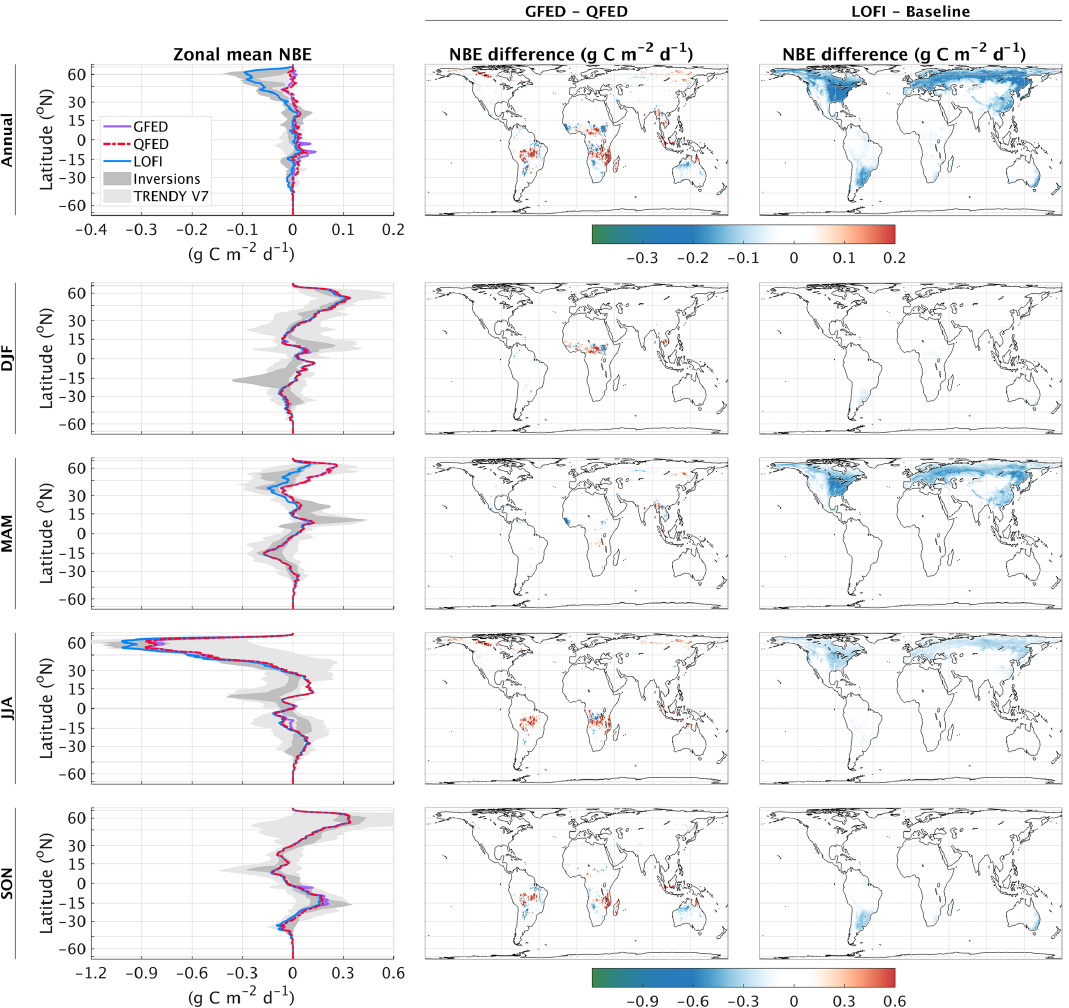
Figure A3. Climatologies (2003–2015) of NBE from the fluxes using GFED (solid purple) and QFED (dash–dot red) biomass burning and the LoFI fluxes (solid blue) for comparison. The first row represents the annual total, and each subsequent row represents a different season. The left column depicts zonal means of the baseline fluxes using GFED and QFED, the range of the inversion ensemble (dark grey), and the range of the TRENDY V7 ensemble (light grey); the middle column depicts the distance of the baseline fluxes using GFED to the range of the inversion ensemble; and the right column depicts the difference of the baseline fluxes using QFED with those using GFED, i.e., the difference of QFED with